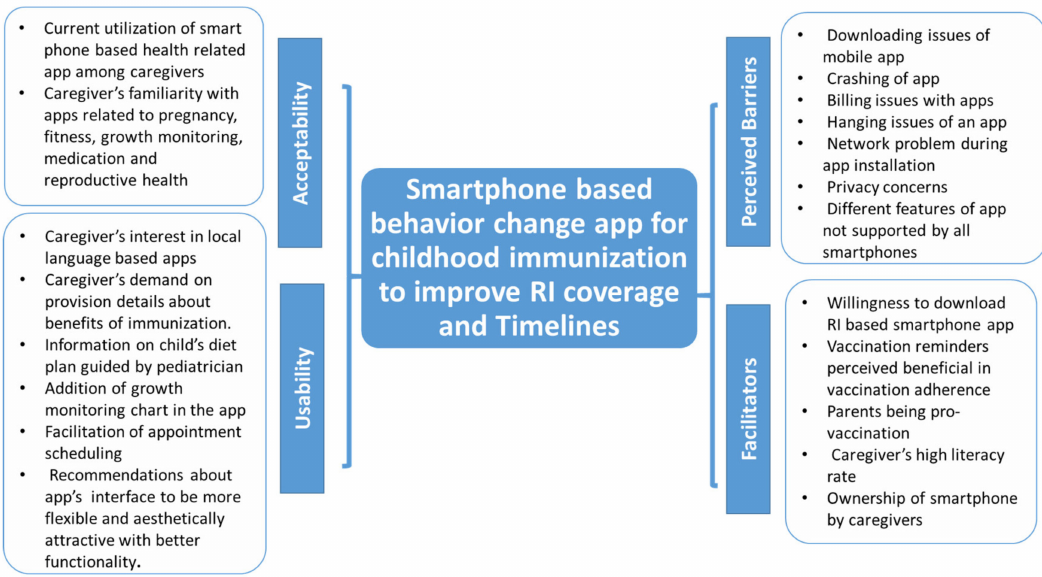
Figure 1. Perceptions of caregivers towards the smartphone-based behavior-change app for improving childhood routine immunization